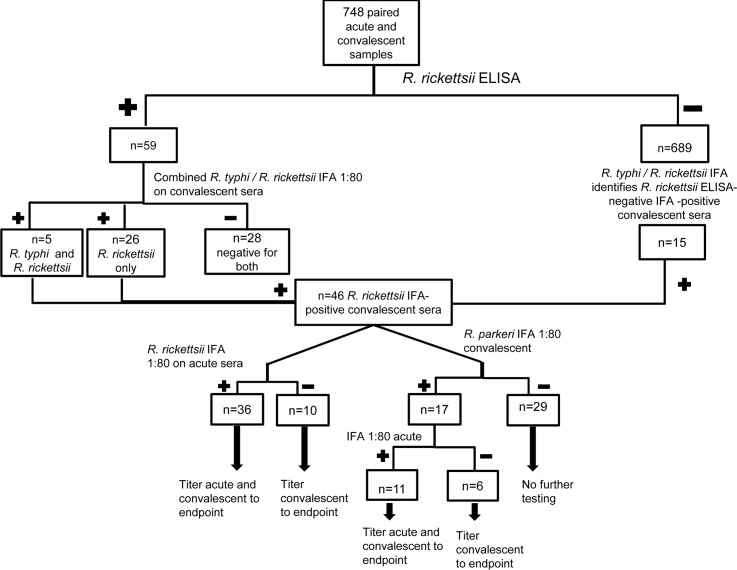
Flow diagram depicting approach to serological evaluation of convalescent and acute phase sera for IgG antibodies to spotted fever group rickettsiae, including ELISA and IFA for R. rickettsii and IFA for R. parkeri.Note that the IFA substrate slides used resulted in simultaneous tests for both R. rickettsii and R. typhi; those samples identified with R. typhi IFA antibodies were then included in the R. typhi tally (Fig 2) if not R. typhi ELISA reactive.